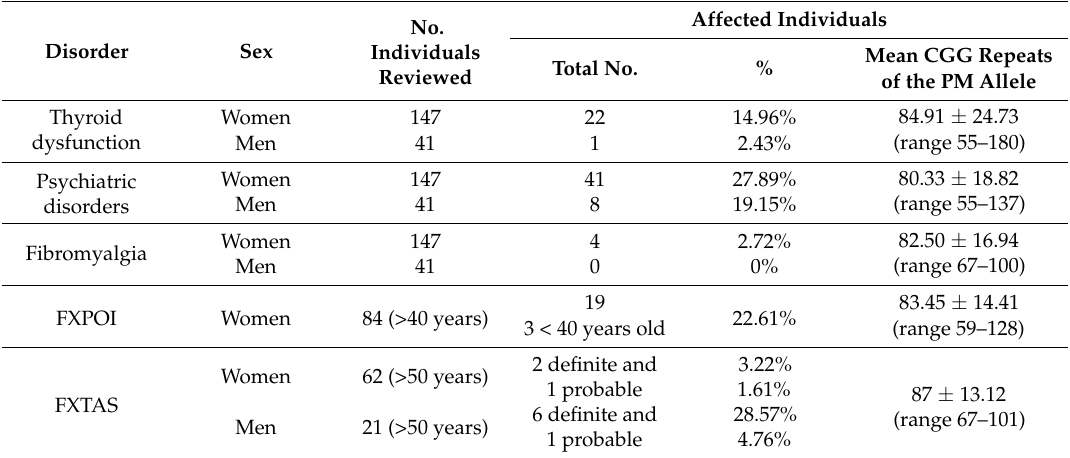
Table 1. Distribution of premutation (PM) carriers by disorder and